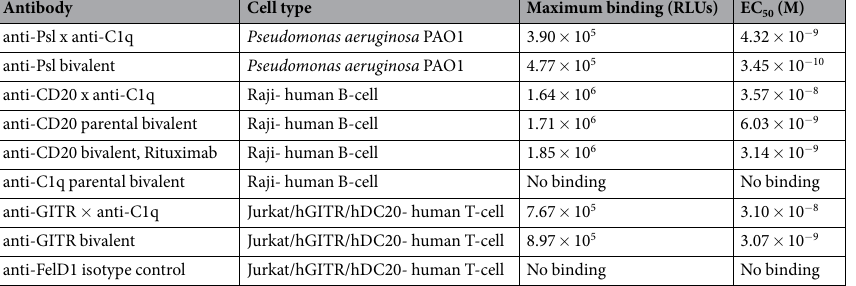
Table 2. Binding characteristics of parental bivalent and C1q-targeting bispecific antibodies. C1q-recruiting bsAbs bind to target cells with high affinity. Binding of antibodies to target cells was determined using ELISA (anti-Psl x anti-C1q and anti-CD20 x anti-C1q) or flow cytometry (anti-GITR x anti-C1q). Shown are maximum binding values for the antibody obtained in each assay and EC 50 values for